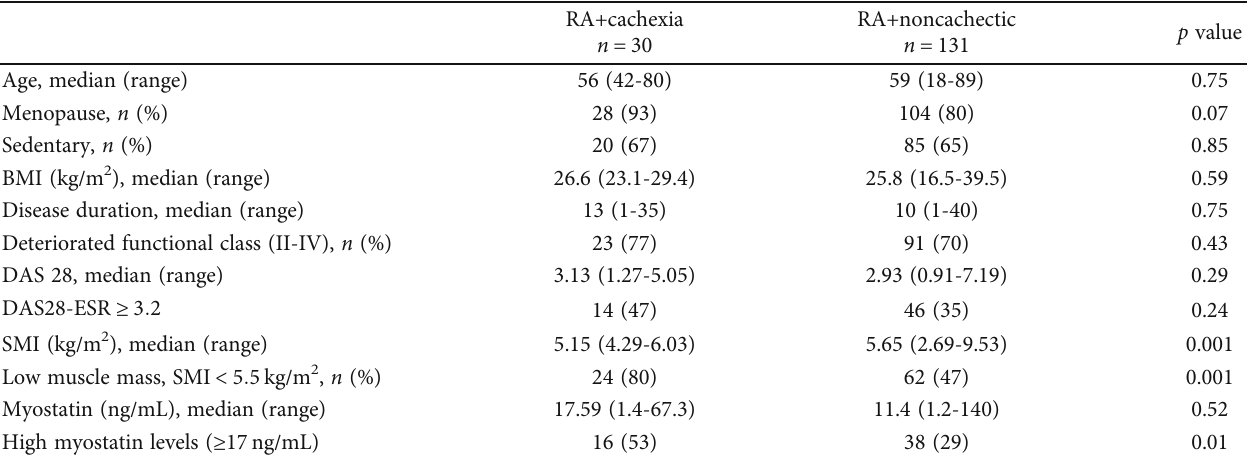
Table 3: Comparison of clinical characteristics between RA patients with and without cachexia in the univariable analysis.